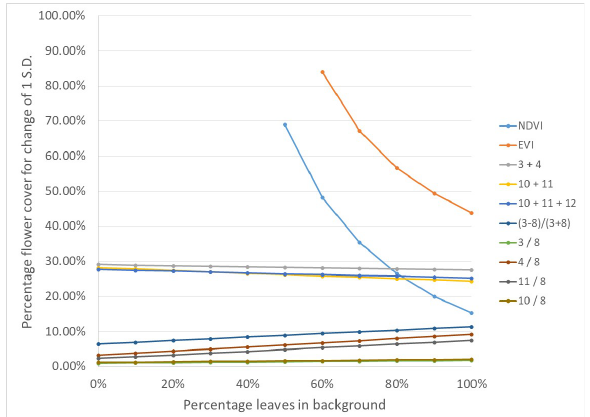
Figure 8. Percentage cover of flowers require to change the reflectance by 1 standard deviation for different background ratios of ground and leaves for MODIS derived